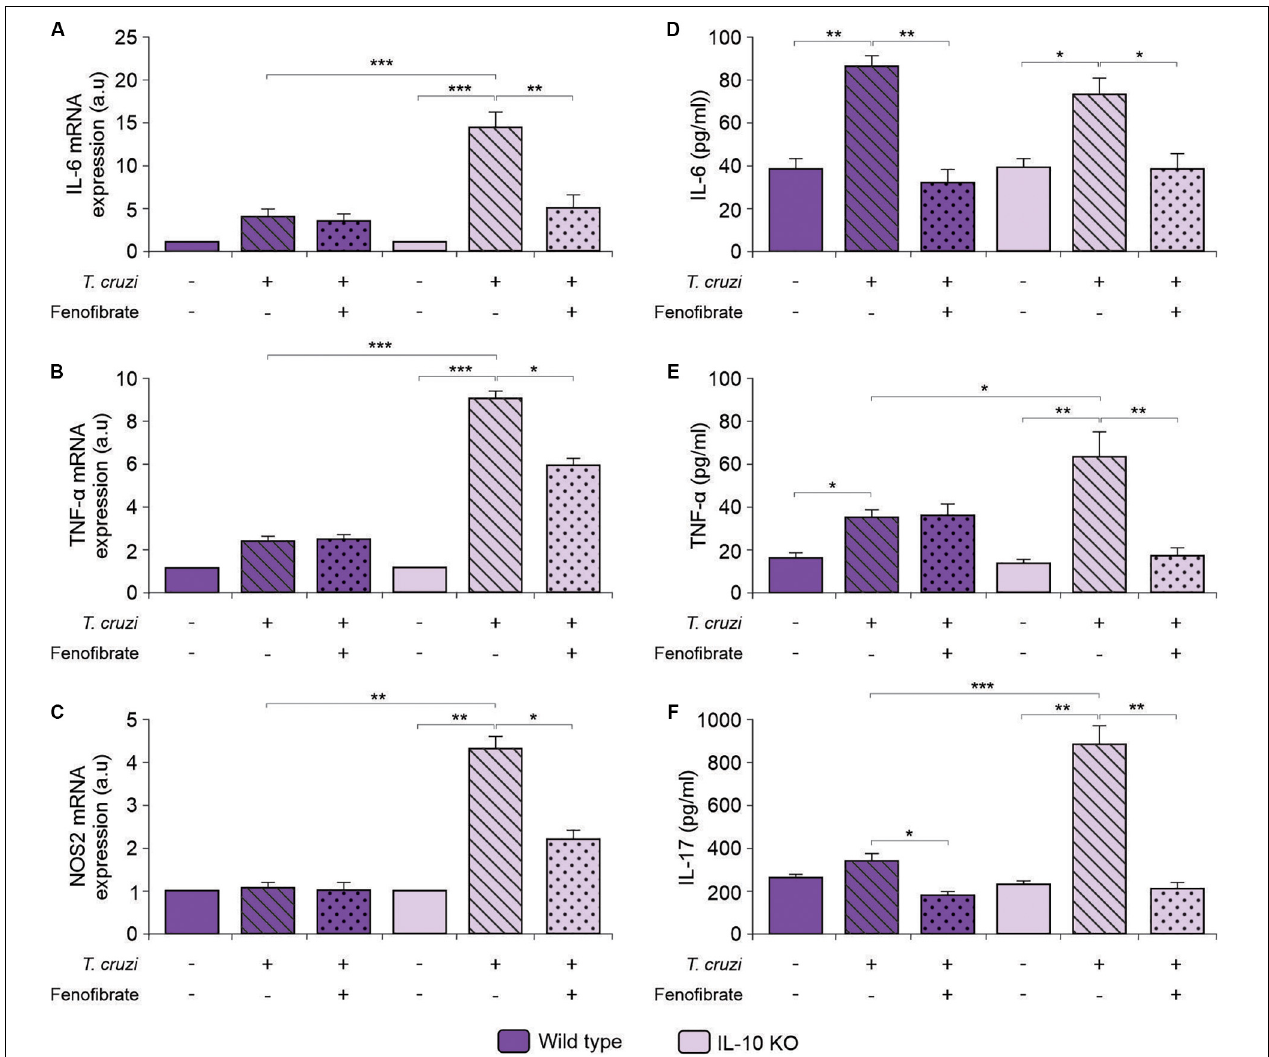
FIGURE 7 | Assessment of the expression and concentration of proinflammatory mediators. Expression of IL-6 (A) , TNF- α (B) , and NOS2 (C) was determined by qRT-PCR in heart homogenates of uninfected, T. cruzi- infected, and T. cruzi- infected fenofibrate-treated WT and IL-10 KO mice. Concentration of IL-6 (D) , TNF- α (E) , and IL-17 (F) was measured in sera from uninfected, T. cruzi- infected, and T. cruzi- infected fenofibrate-treated WT and IL-10 KO mice. Differences between groups were analyzed by ANOVA (mean ± SEM) followed by Tukey post hoc test. Differences were considered significant when p < 0.05. 7 mice per group, 3 replicate experiments. * p < 0.05; ** p < 0.01; and *** p <